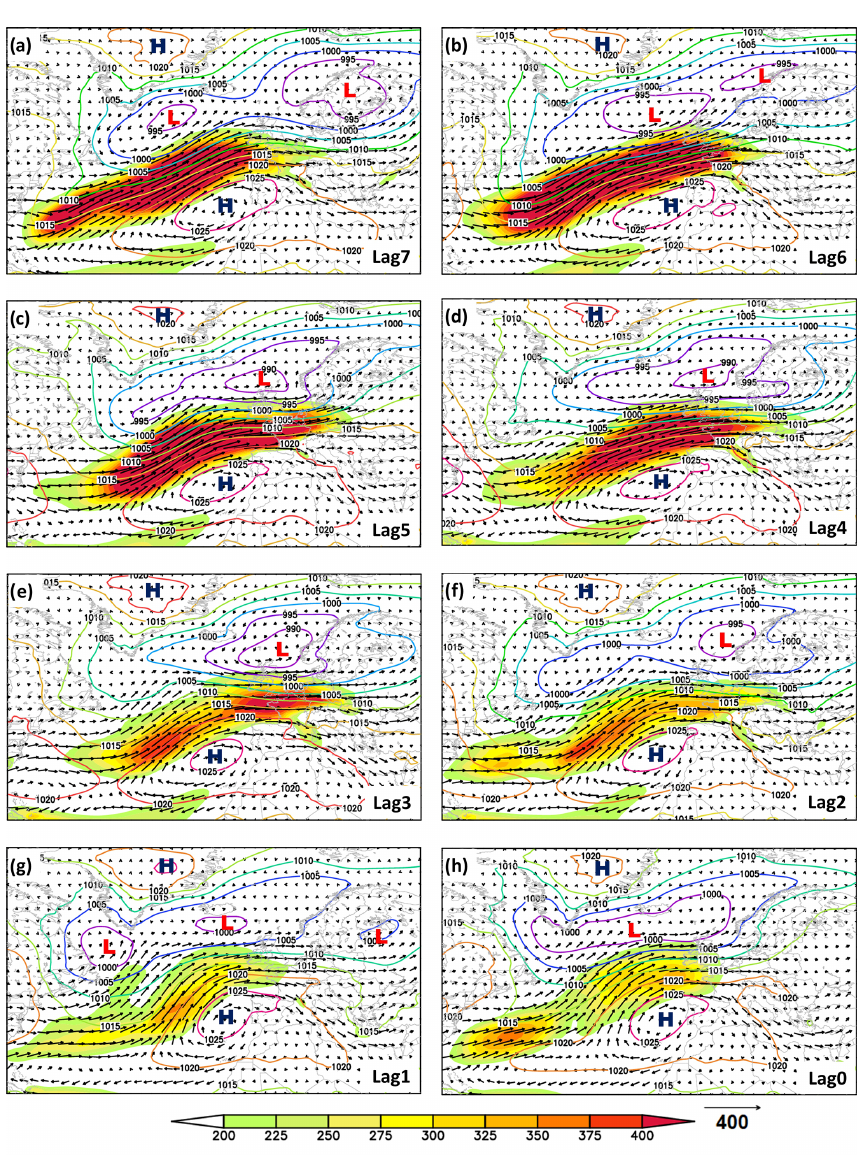
Figure 11. Composite of the mean sea level pressure (SLP; colored contour lines), magnitude of the integrated water vapor transport (IVT; shading) and the direction of the integrated water vapor transport (vectors) for different time lags (0–7d) for the 10 highest flood peaks recorded at the Köln gauging station (see Table 1). Units: SLP (hPa) and IVT (kgs − 1 m − 1